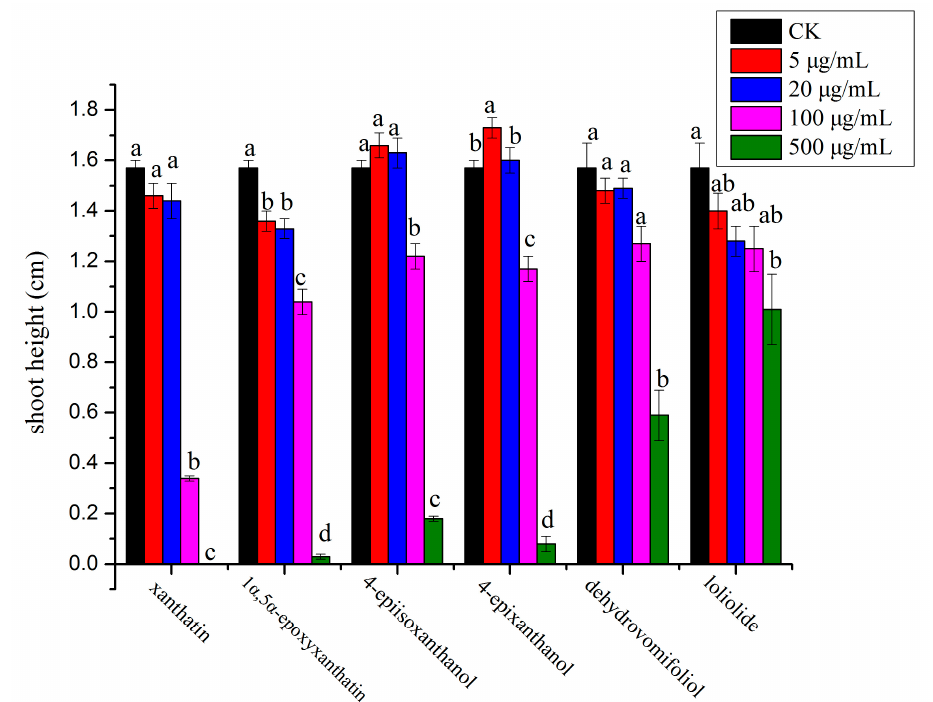
Figure 4. Phytotoxic effect of isolated compounds on shoot growth of A. retroflexus . Different letters represent a significant difference at p < 0.05 level according to Fisher’s LSD test.